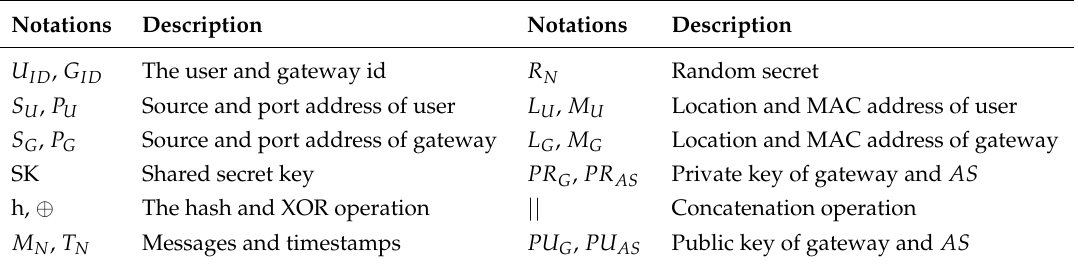
Table 1. Notations and